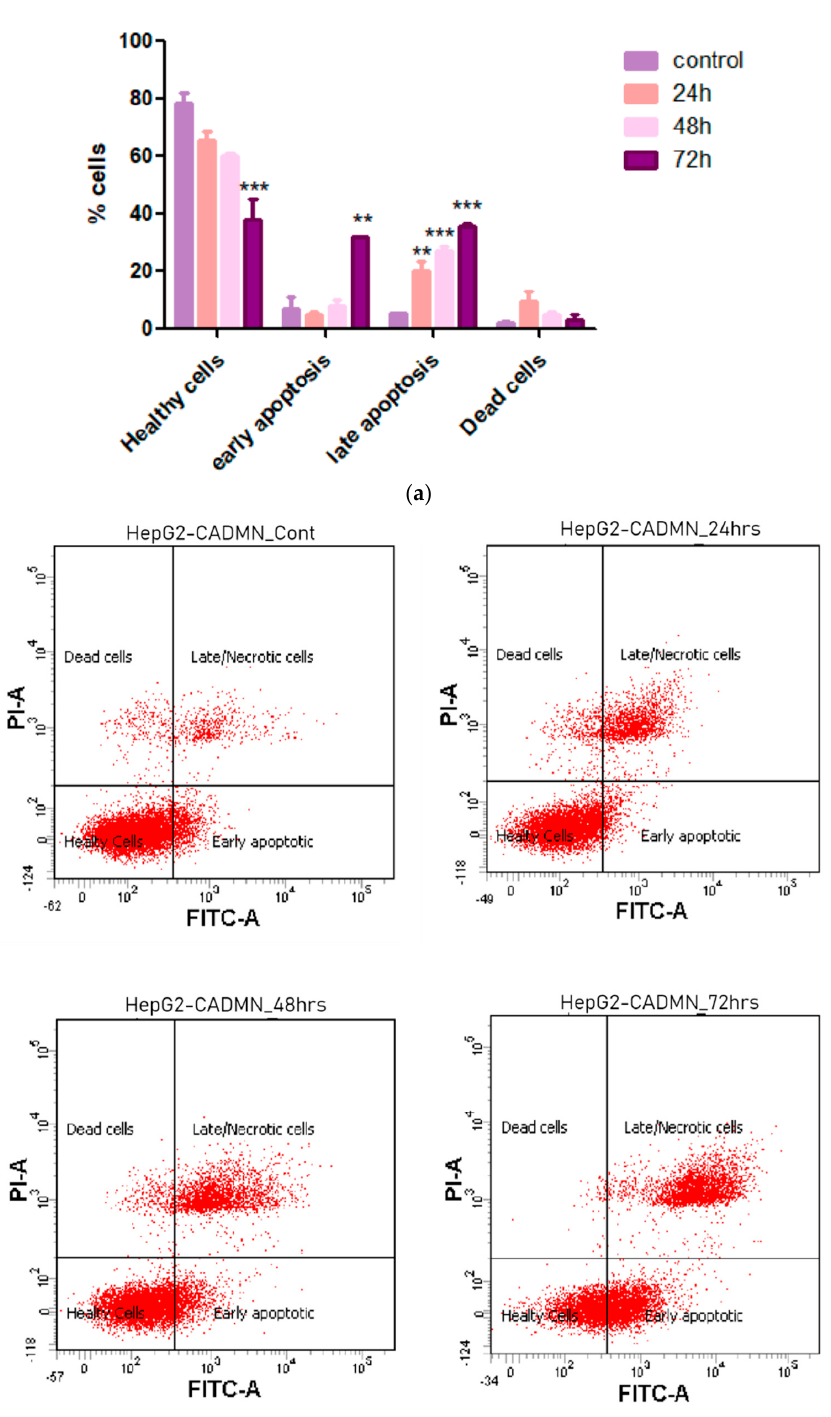
Figure 4. Annexin V analysis of untreated cells and CADMN-treated HepG2 cells at 24, 48, and 72 h using flow cytometry. ( a ) The calculated cells percentage at different stages. ( b ) Cells distribution at several phases. Data were presented as mean ± SD. * p < 0.05, ** p < 0.01, *** p < 0.001 indicates significant differences as compared to untreated group (control).